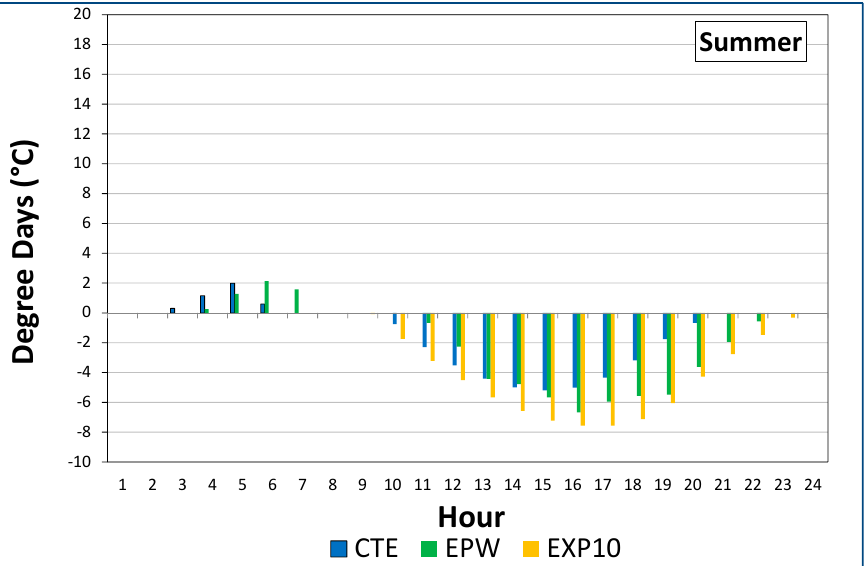
Figure 6. Hourly degree-days in summer obtained for three climate databases of Madrid: CTE, EPW and Exp10.